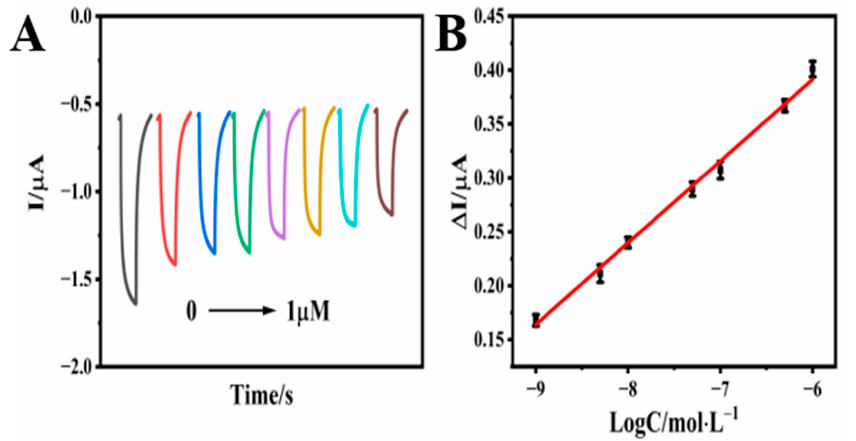
Figure 5. ( A ) Photocurrents of the MIP/ β -Bi 2 O 3 /ITO PECs to different concentrations of BPA (0, 1 nM, 5 nM, 10 nM, 50 nM, 100 nM, 0.5 µ M and 1 µ M). ( B ) Linear calibration curves for MIP/ β -Bi 2 O 3 /ITO (error bars indicate the standard deviation (n = 3)). Table 1. Comparison of different BPA detection methods.